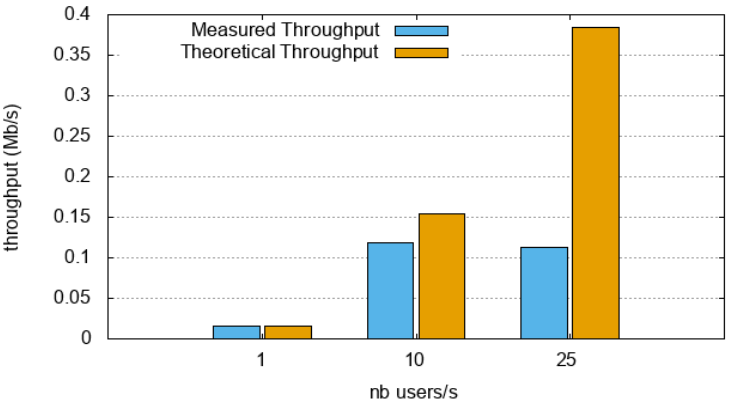
Figure 10. Throughput evaluation under stress/load test on node1 (IoTBnB O-MI node).